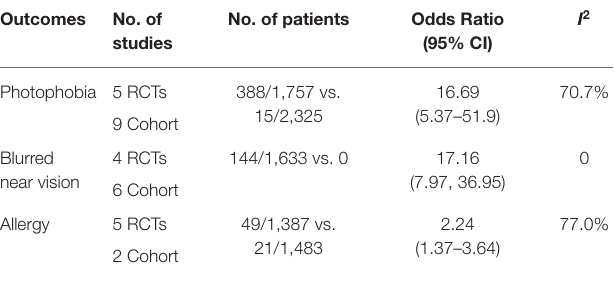
TABLE 3 | Adverse events in the atropine groups vs control group during the treatment of myopia in children.